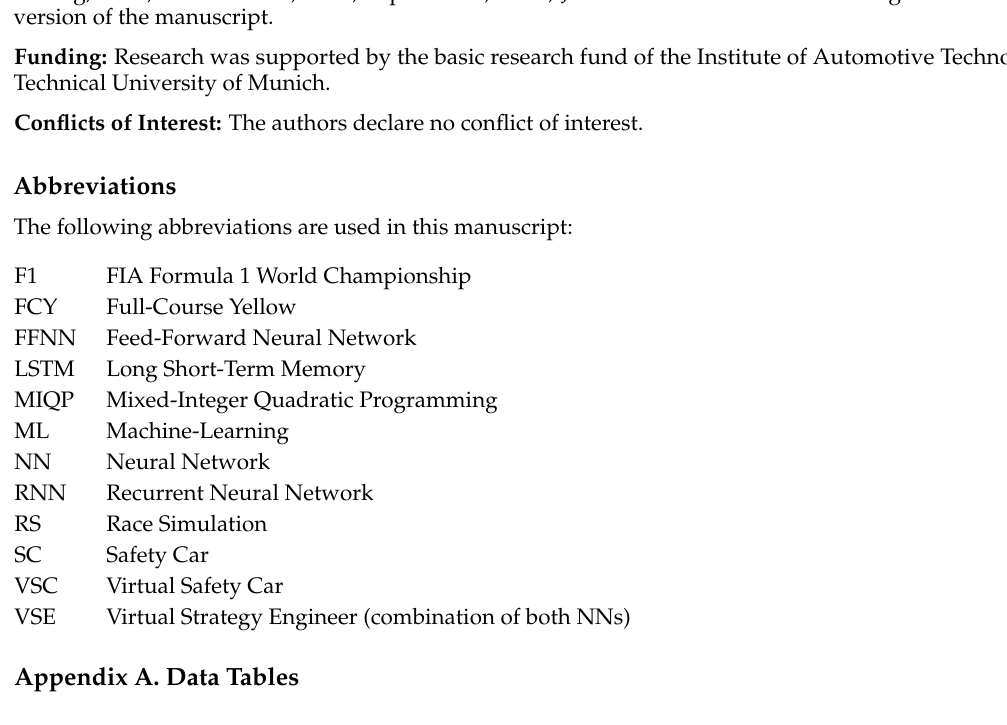
Table A1. The race track categorization is based on the hardest absolute tire compound available